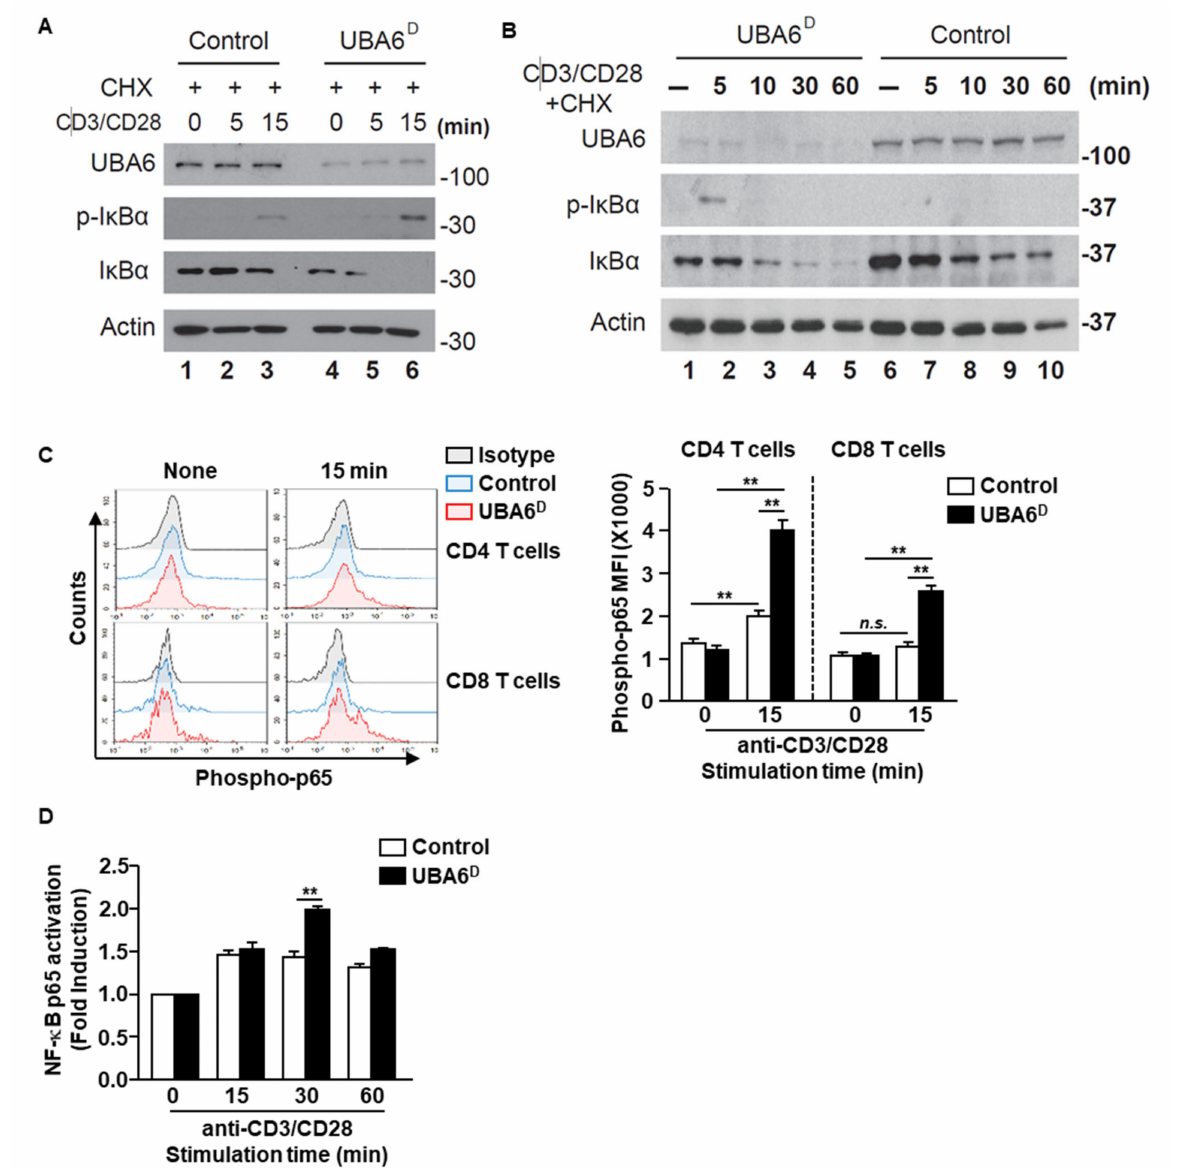
Figure 5. UBA6 is required for the inhibition of NF- κ B activation in CD8 + T cells. Sorted naïve CD8 + T cells were activated with soluble anti-CD3 and anti-CD28 Ab for the indicated times. ( A , B ) Cells were activated in the presence of 50 µ M cycloheximide. Whole cell lysates were prepared and analyzed by western blot analysis using p-I κ B α , I κ B α , and UBA6 Abs to detect these proteins after ( A ) shot time and ( B ) long time stimulation with anti-CD3 and anti-CD28 Ab. ( C ) Flow cytometry analyses of phospho-p65 the levels in CD4 and CD8 T cells. Cells were unstimulated (left) or stimulated for 15 min (right) (left panel). MFI of phosphor-p65 levels are shown (right panel) ( n = 4, two-way ANOVA, mean ± SEM, ** p < 0.01). ( D ) Nuclear transcription factor NF- κ B p65 activity was measured by ELISA-based TransAM NF- κ B p65 kit (Active Motif) according to the manufacturer’s protocol. Data are representative of three independent